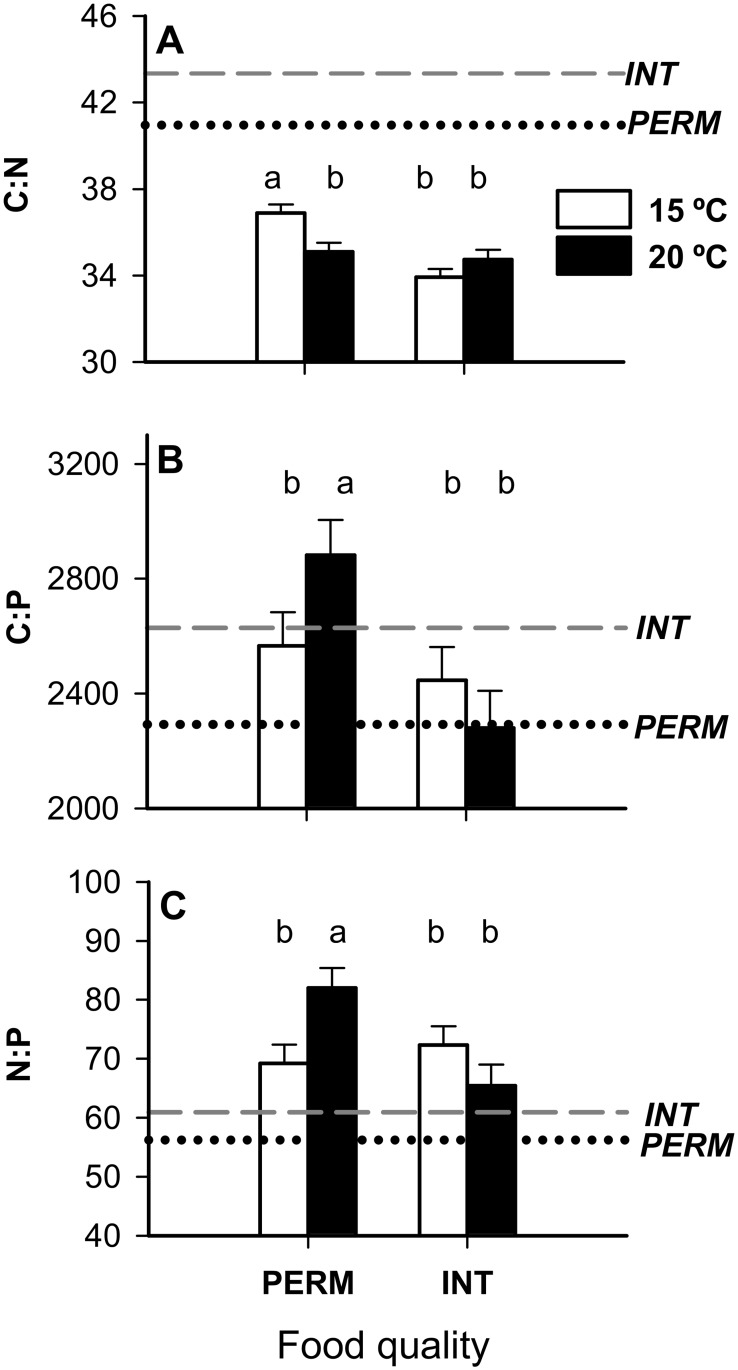
Molar ratios in feces of E. berilloni (n = 11–15) maintained at 15 and 20°C and fed PERM and INT leaves.The results are the mean (± SE) for the different treatments. The least-square means are shown to correct for the DM effect (ANCOVAs, P<0.100). The horizontal lines represent molar ratios of leaves conditioned under PERM (gray dashed line) and INT (black dotted line) conditions. Different letters indicate significant differences based on independent pairwise comparisons adjusted by the Dunn-Sidak correction at α = 0.05.